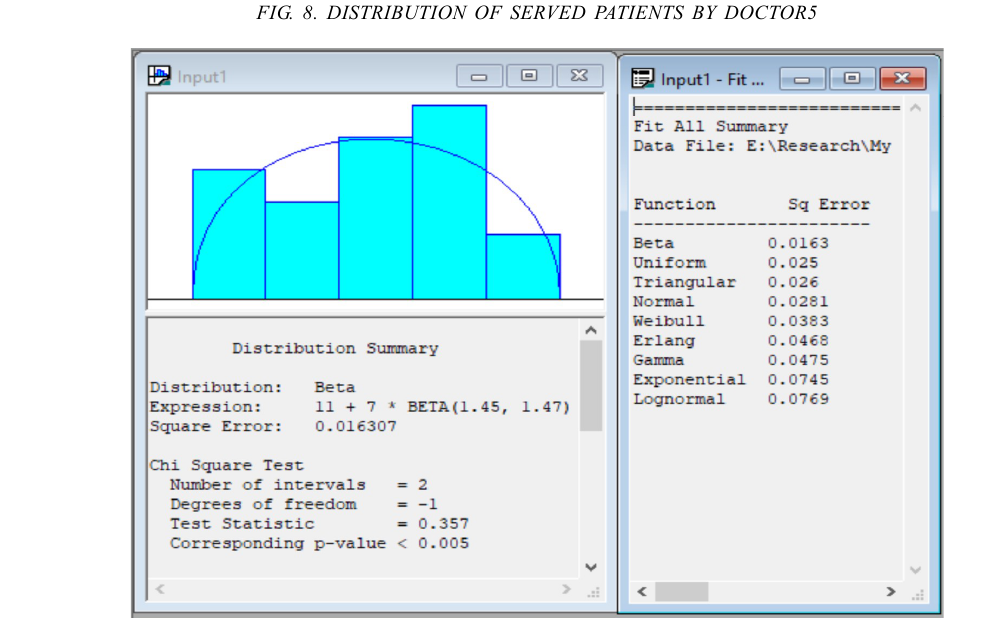
FIG. 9. DISTRIBUTION OF SERVED PATIENTS BY